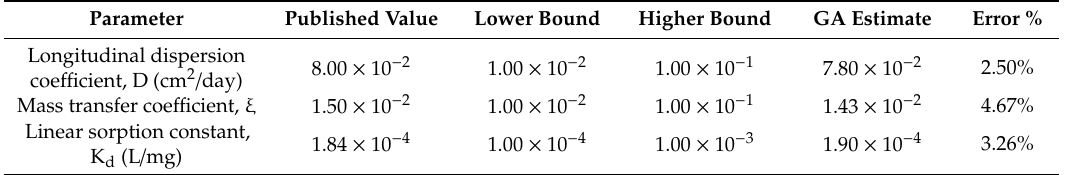
Figure 2. Comparison of results from PGA-estimated parameters and the published parameters for benchmark problem-1. Table 2. Comparison of the PGA-estimated parameters with published values along with their bounds and percentage error for benchmark problem-1.